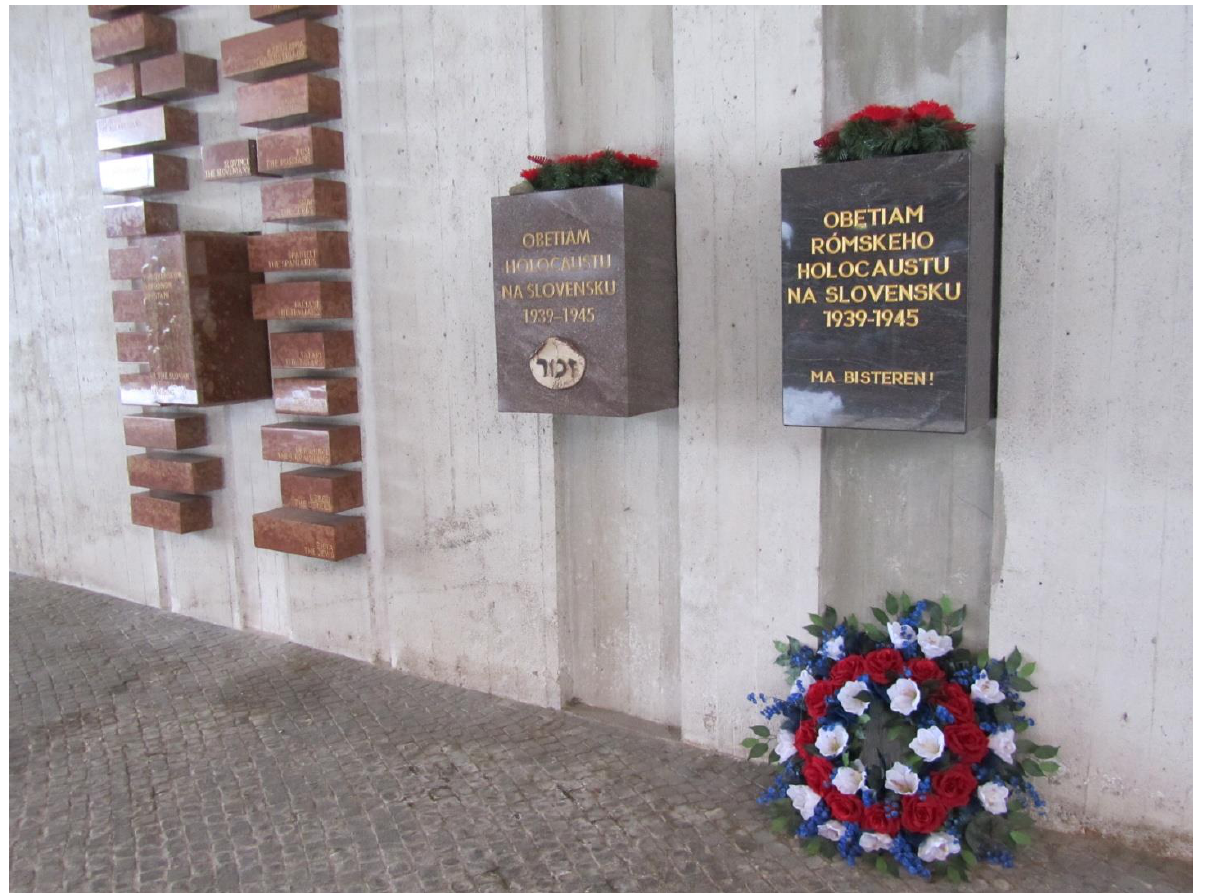
Figure 1. Roma memorial at the Museum of Slovak National Uprising (2006), Banská